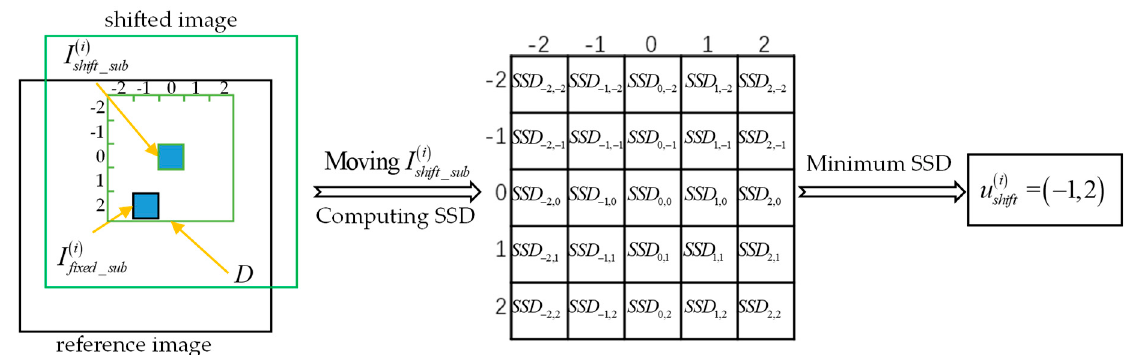
Figure 5. The procedure of calculating the translational vector of the i − th sub-image.